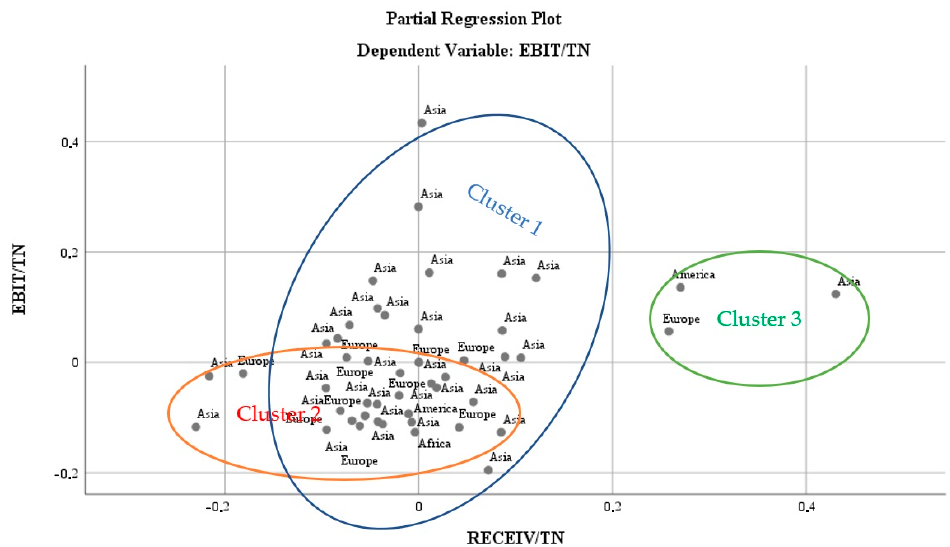
Figure 9. Clusters of distribution of the value of the regressor self-financing capacity in relation to the overall economic performance rate.